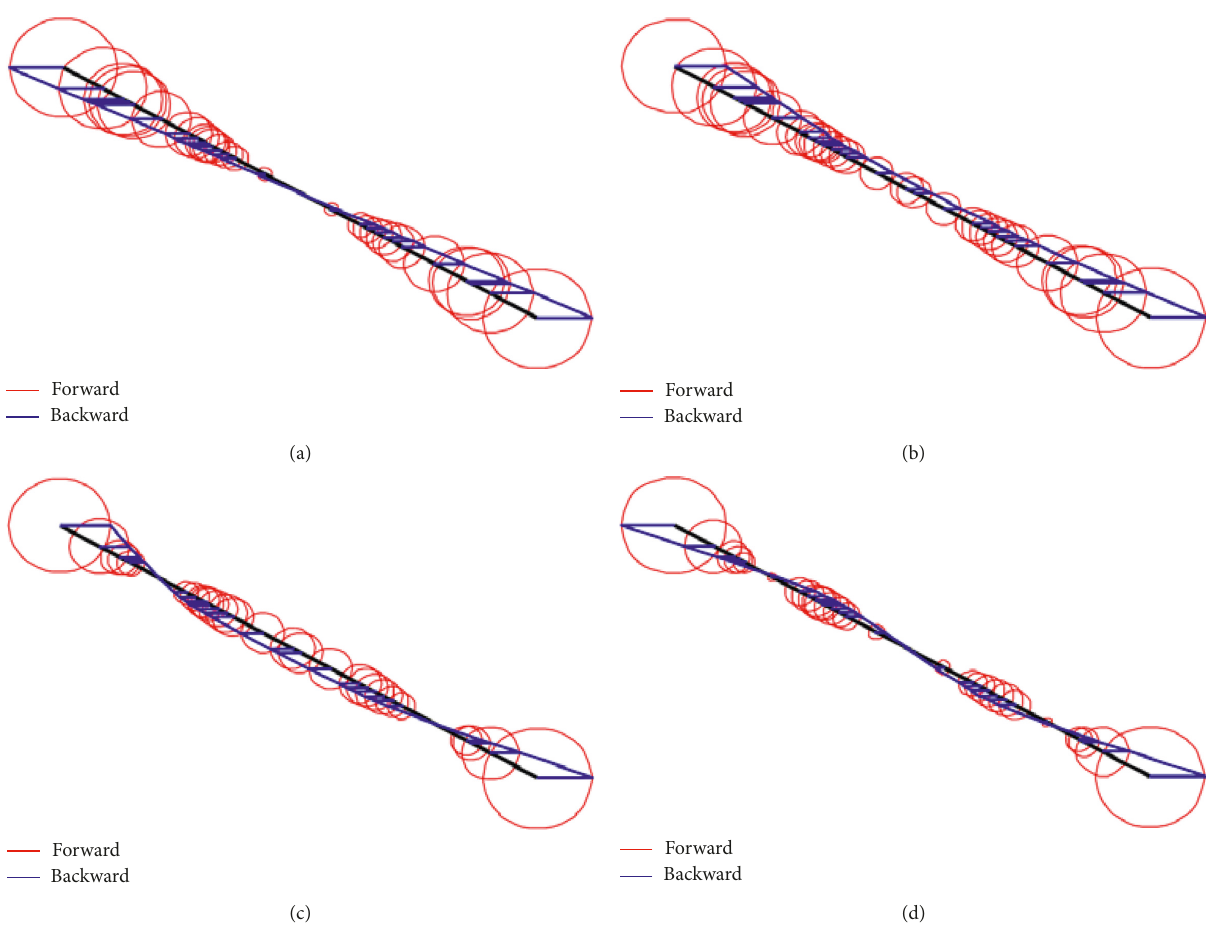
Figure 5: Modal shapes for every order critical speed. (a) Conical whirling modal shape. (b) Cylindrical whirling modal shape. (c) First- order bending modal shape. (d) Second-order bending modal shape.